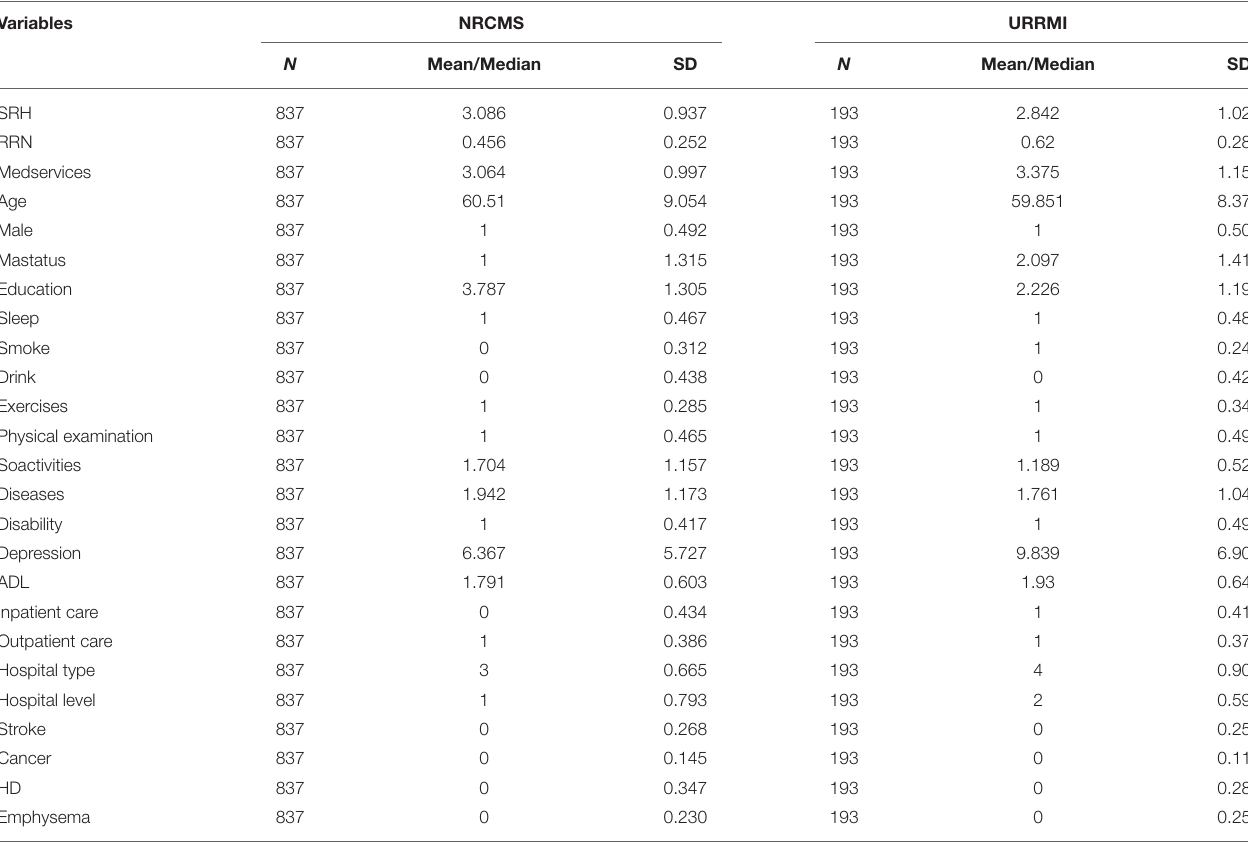
TABLE 1 | Descriptive analysis in rural aged 45 years and older, presented as mean / median, SD, N.